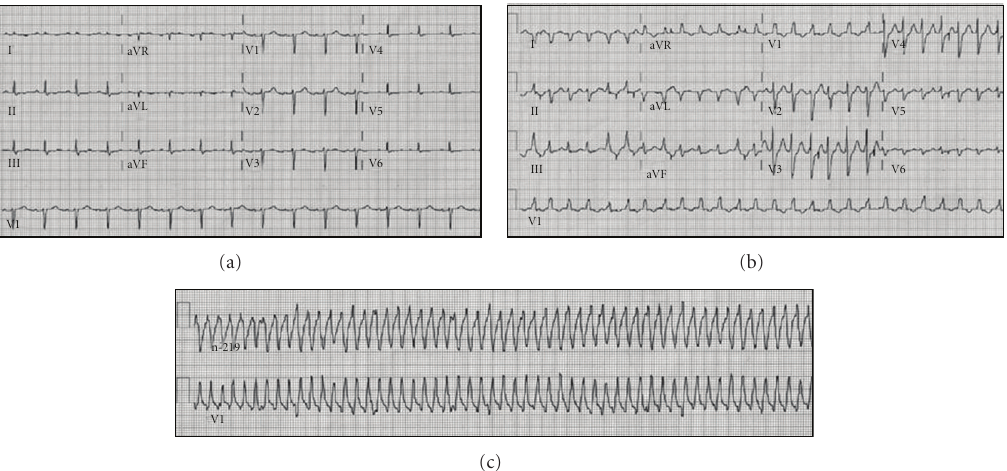
Figure 1: ECGs taken during index admission. Normal sinus rhythm. Sustained monomorphic ventricular tachycardia with right bundle branch block morphology and QRS duration of 130ms suggesting a fascicular origin. Rhythm strip of faster broad complex